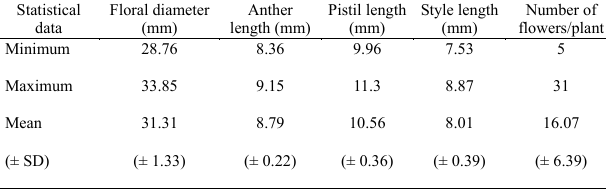
Table 1 . Minimum, maximum and mean (± standard deviation) values of the floral diameter, length of anther, pistil and style and number of open flowers per tomato plant in a greenhouse of grape tomato, in Araguari, Minas Gerais state, Brazil. Statistical